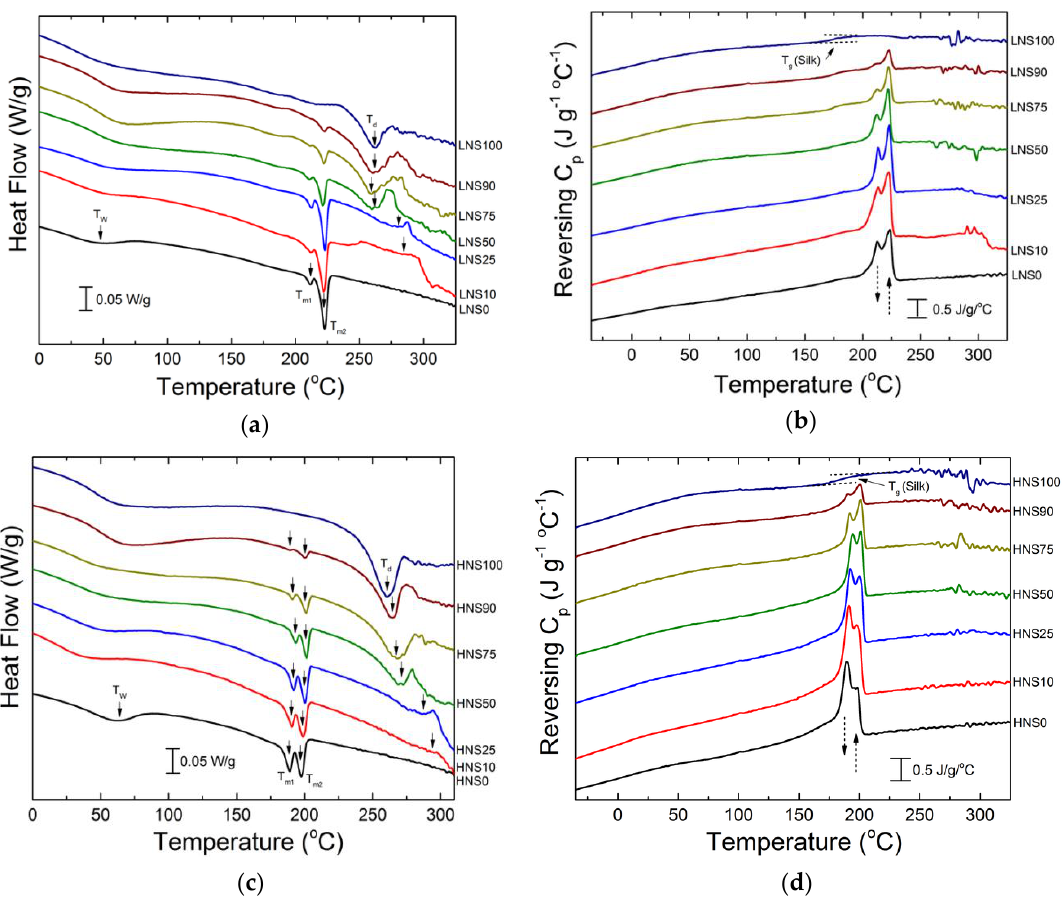
Figure 5. Differential scanning calorimetry (DSC) heat flow and reversing heat capacity of ( a , b ) LNS films and ( c , d ) HNS films.